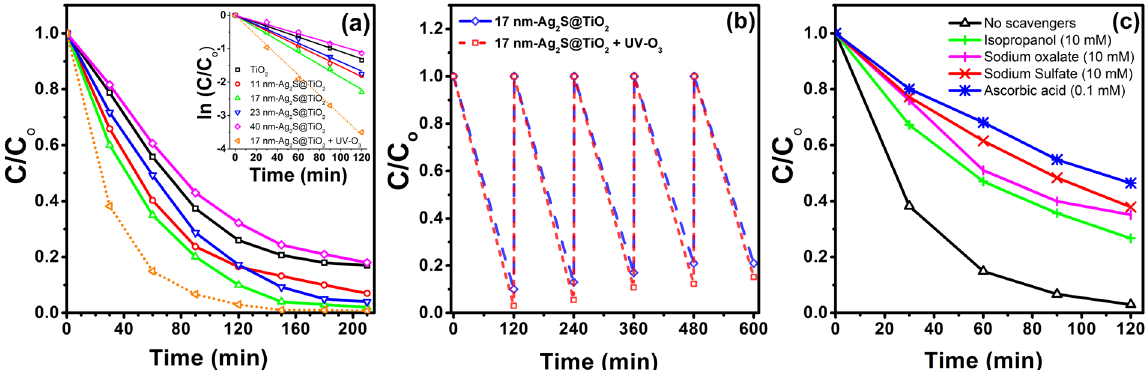
Figure 6. ( a ) Comparative photocatalytic performance (C/C o ) of pure and Ag 2 S sensitized TiO 2 NFs under simulated solar light irradiation (inset: pseudo-first order kinetics), ( b ) Photocatalytic performance of 17 nm-